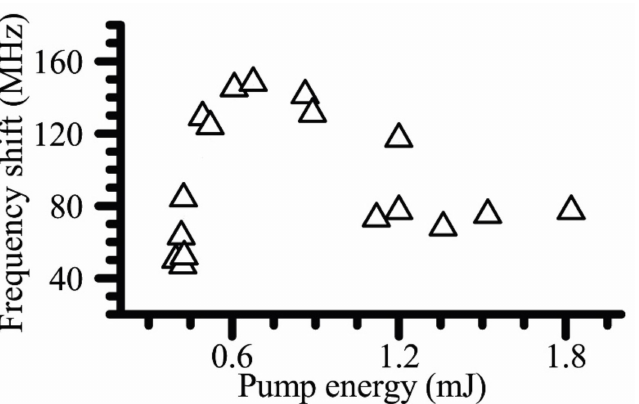
Figure 6. Spectral shifts of the anti-Stokes backward SRMS signal vs the pump pulse energy in the nanosecond pulse interaction regime, experimental points are given by triangles.